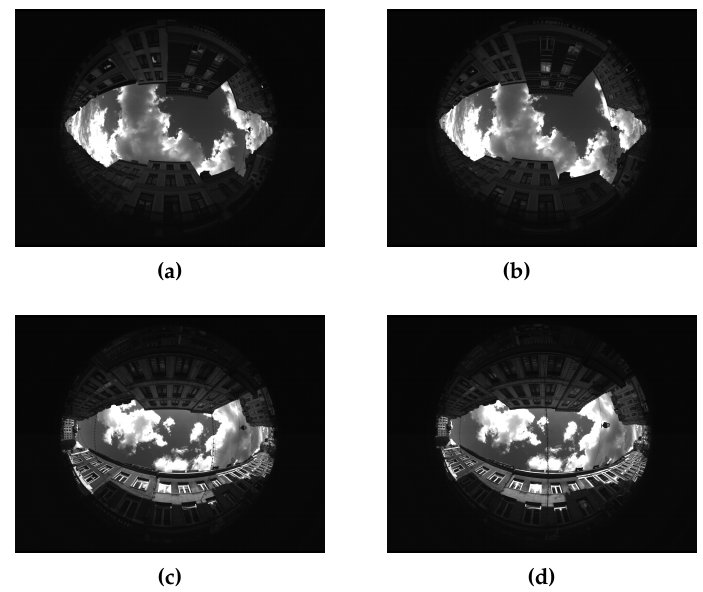
Figure 3. Fisheye views of presented scenes. ( a , b ) Cap3/0900, rear and front; ( c , d ) Cap4/1560, rear and front.